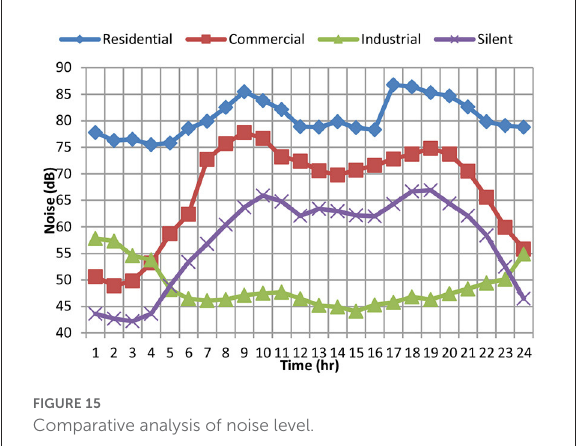
FIGURE15 Comparative analysis of noise